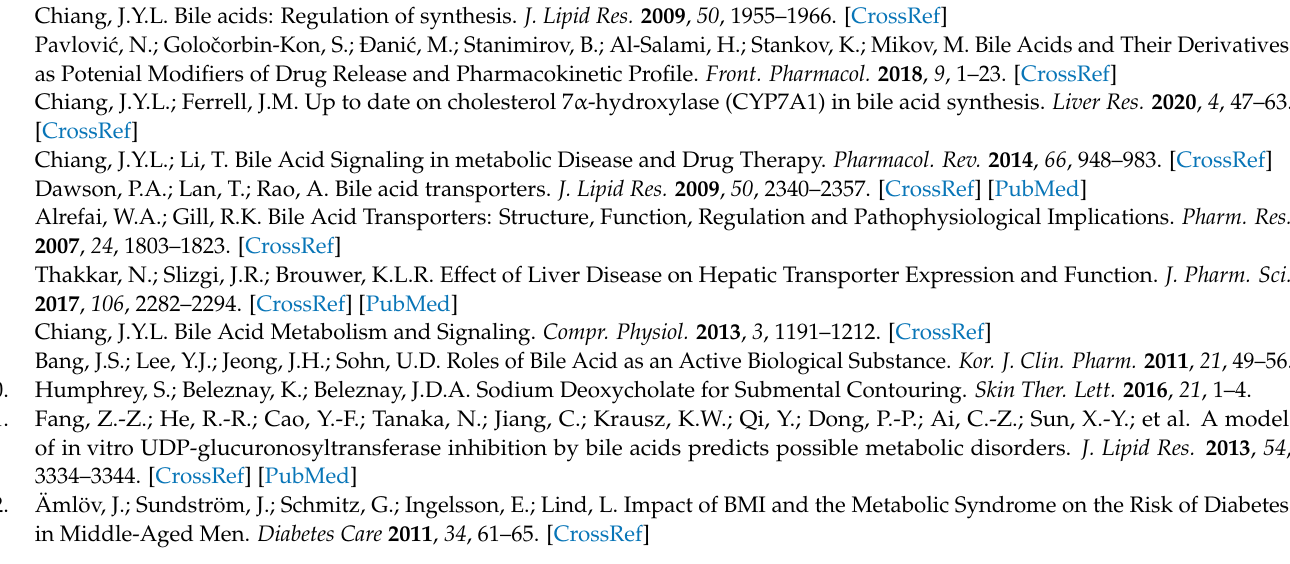
Table S5: Cell viability of MT921 (0–100 µ M) in cryopreserved human hepatocytes, Table S6: Effects of MT921 (1, 10, and 100 µ M) on CYPs, UGTs, and transporter mRNA expression in cryopreserved human hepatocytes, Table S7: MT921 clinical studies, Table S8: Drug-dependent parameters of the MT921 PBPK model, Table S9: MRD values of predicted MT921 plasma concentration, Table S10: Observed and predicted MT921 AUC and Cmax values with mean GMFE values, Table S11: Sum- mary of clinical studies used for the amlodipine model, Table S12: Drug-dependent parameters of the amlodipine PBPK model, Table S13: MRD values of predicted amlodipine plasma concentration, Table S14: Observed and predicted amlodipine AUC and Cmax values with mean GMFE